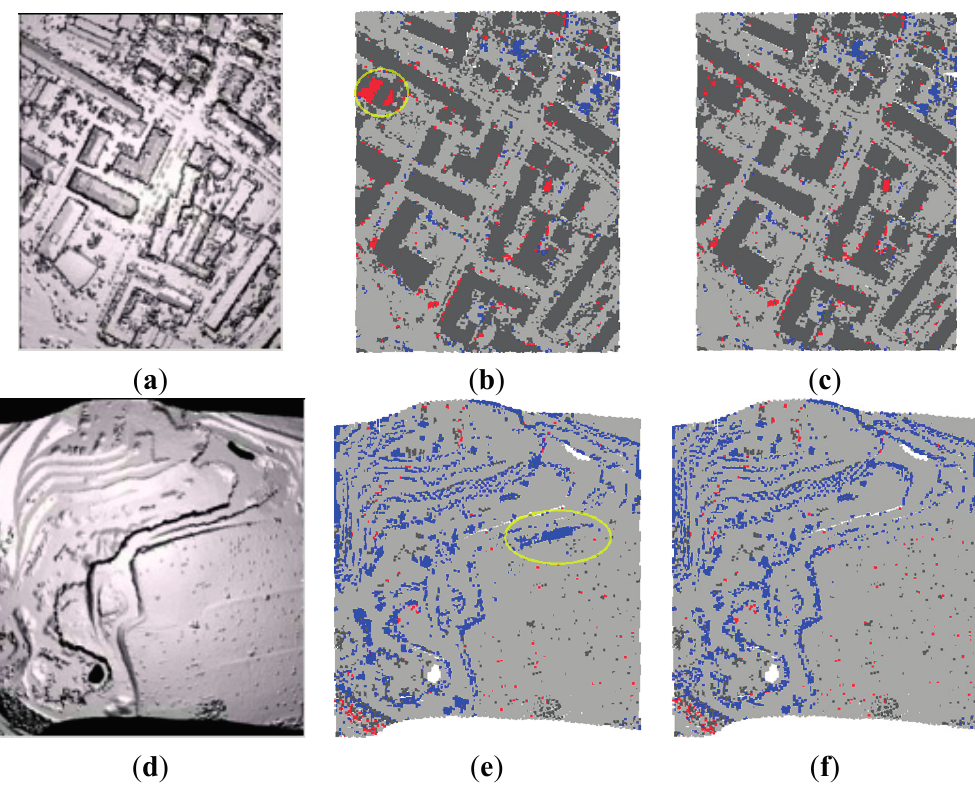
Figure 15. Comparison of the filtering results of the methods proposed by Li et al. [38] and this paper for Samples 12 and 53: ( a ) and ( d ) are the DSMs generated from the raw point clouds; ( b ) and ( e ) are the results from Li et al. [38]; ( c ) and ( f ) are the results from the filter proposed in this paper.